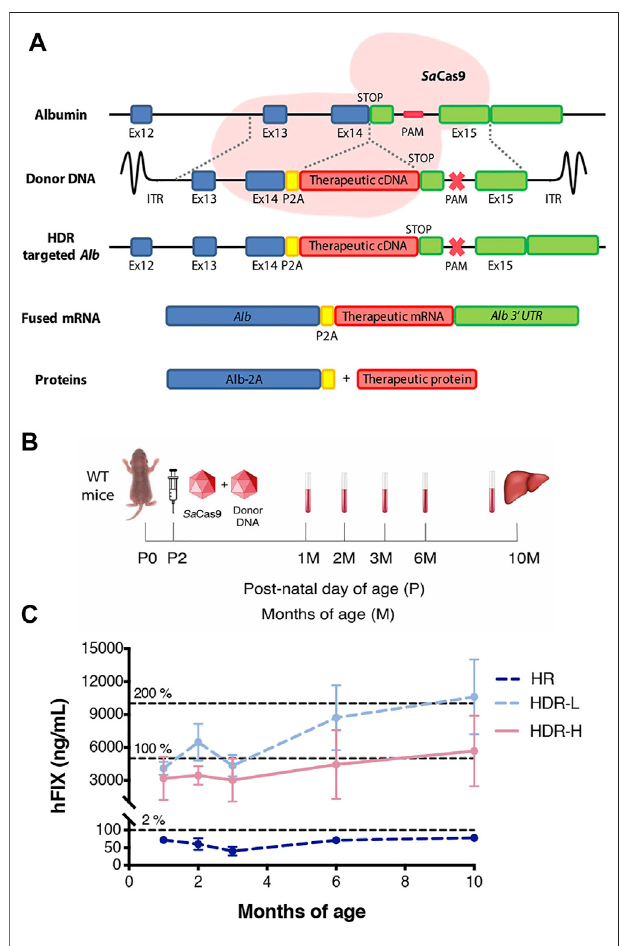
FIGURE 1 | In vivo gene targeting of hFIX into the albumin locus in neonatal wild-type mice. (A) Targeting strategy for integration of donor hFIX cDNA vector, proceeded by the 2A-peptide and fl anked with arms of homology for the albumin locus. Albumin and hFIX are transcribed into a single hybrid mRNA molecule and translated into two separate proteins. The CRISPR/ Sa Cas9 performs a double-strand break in the intron located downstream of the albumin stop codon, enhancing the homologous directed repair rate; (B) Experimental scheme. Wild-type mice were i.v. injected at post-natalday2withonlyrAAV8-donor-hFIX(2.0E11 vg/mouse,HR, n =5)or with rAAV8-donor-hFIX combined to different rAAV8- Sa Cas9-sgRNA8 doses (6.0E10 vg/mouse, HDR L, n = 5; or 2.0E11 vg/mouse, HDR H, n = 5). Blood wascollectedatdifferenttimepointsandmiceweresacri fi cedat10 monthsof age; (C) Plasma hFIX levels were evaluated at 1, 2, 3, 4, 6, and 10 months of age. The dotted lines at 5,000 ng/ml and 10,000 ng/ml represent 100 and 200%,respectively,ofthehFIXlevelspresentinthehealthyhumanpopulation. Values are represented with mean ± SD. Two-way ANOVA (Bonferroni test) Interaction ns ( p = 0.1356), Treatment *** ( p < 0.0001), Time ** ( p =